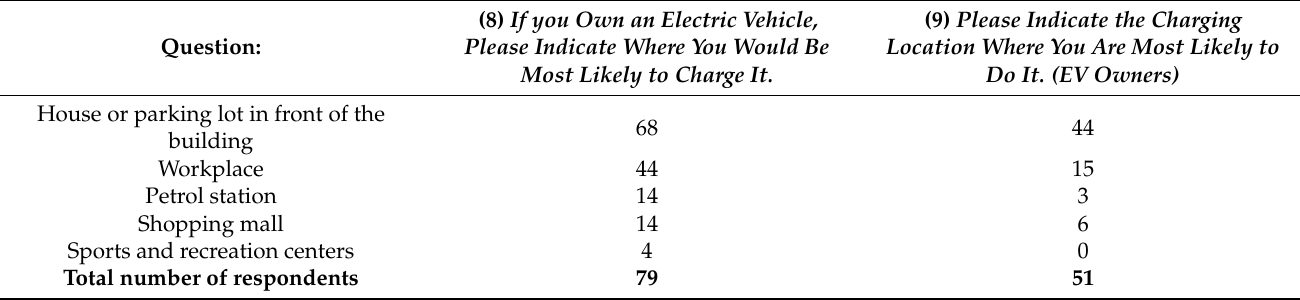
Table A6. Detailed responses to questions (8) and